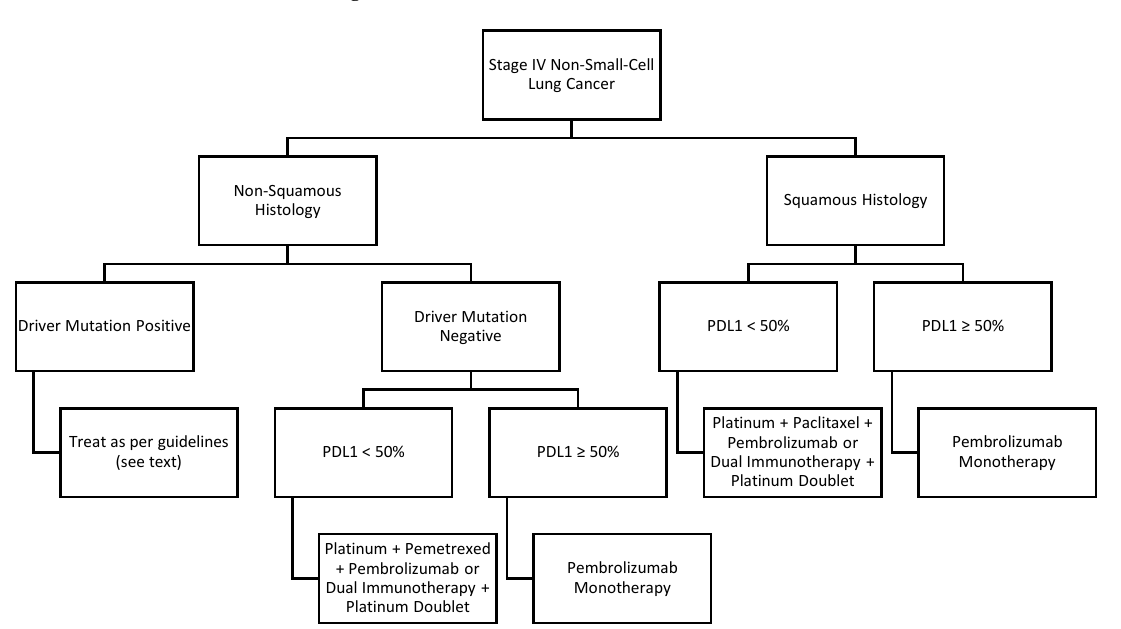
Figure 1. First-line treatment for metastatic non-small-cell lung cancer.